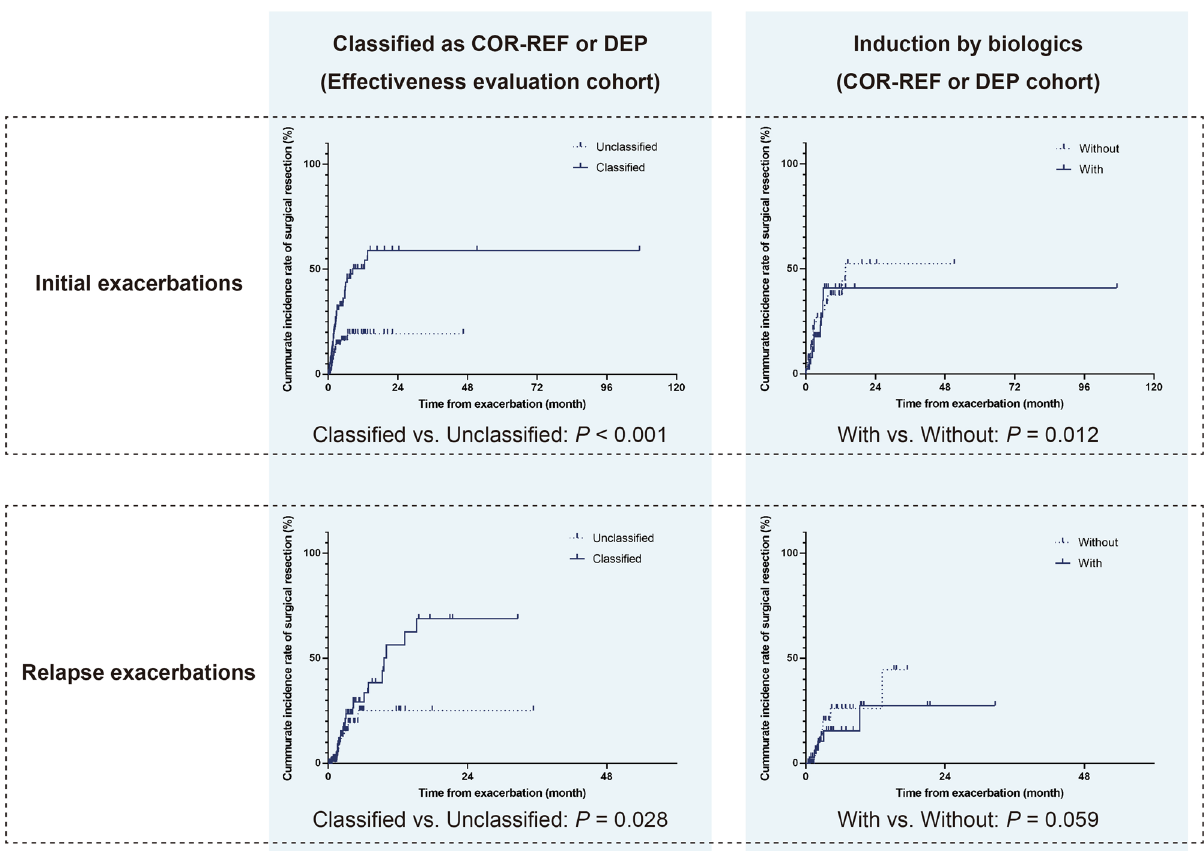
Figure 3. Cumulative incidences of surgical resection in patients with moderate to severe ulcerative colitis exacerbations. The left column: the impact of classified as COR-REF or DEP cohort on cumulative incidence of surgical resection in patients with the effective evaluation cohort. The right column: impact of induction by biologics on cumulative incidence of surgical resection in patients with the COR-REF or DEP